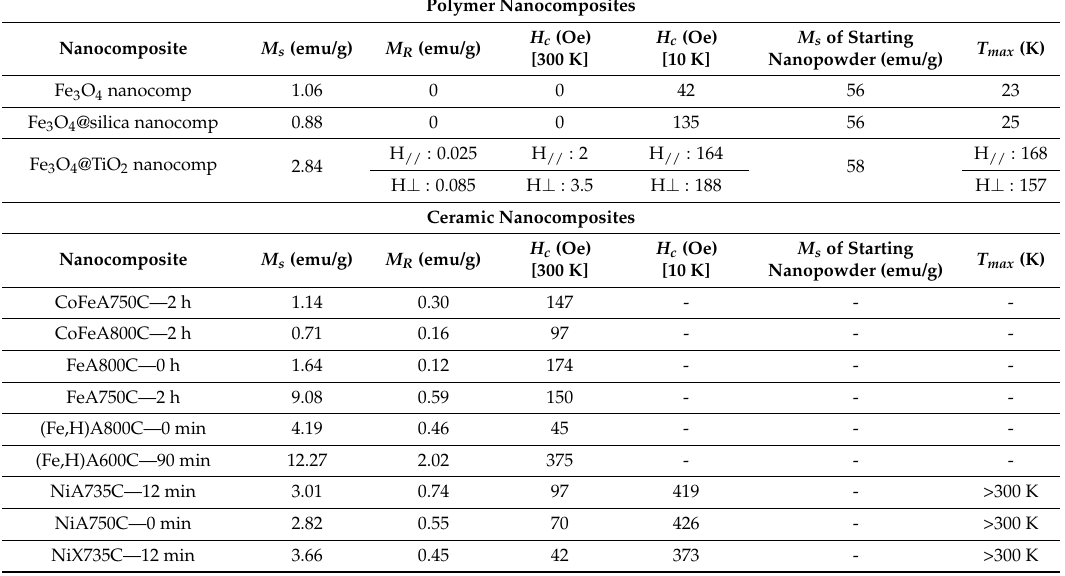
Table 1. Room temperature values of saturation magnetization, remanent magnetization, and coercive field of typical polymer/ceramic nanocomposites; coercive field at low temperature; saturation magnetization of the embedded nanoparticles at room temperature; maximum temperature of the zero-field-cooled (ZFC) curve (close to the blocking temperature of magnetic nanoparticles). Each nanocomposite is identified by the label referred to in the text. Ceramic nanocomposites were not obtained starting from a magnetic